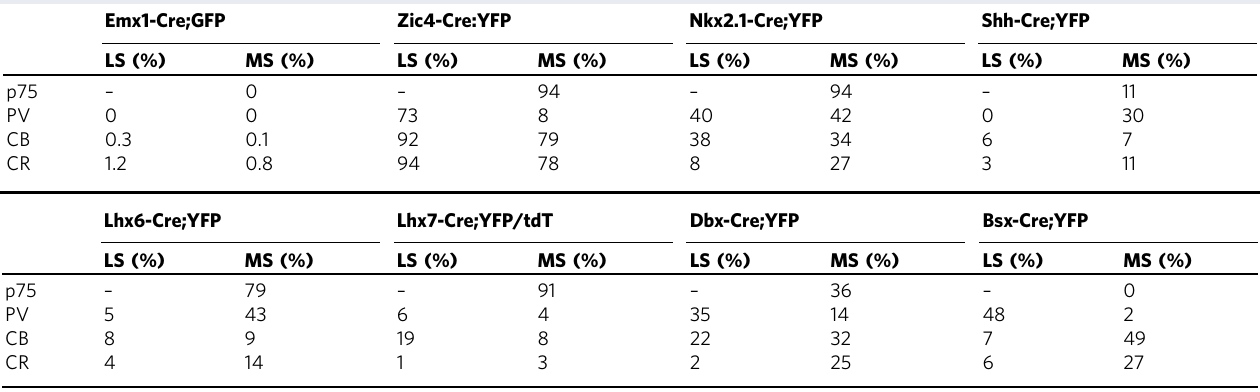
Table 2 Fate-mapping